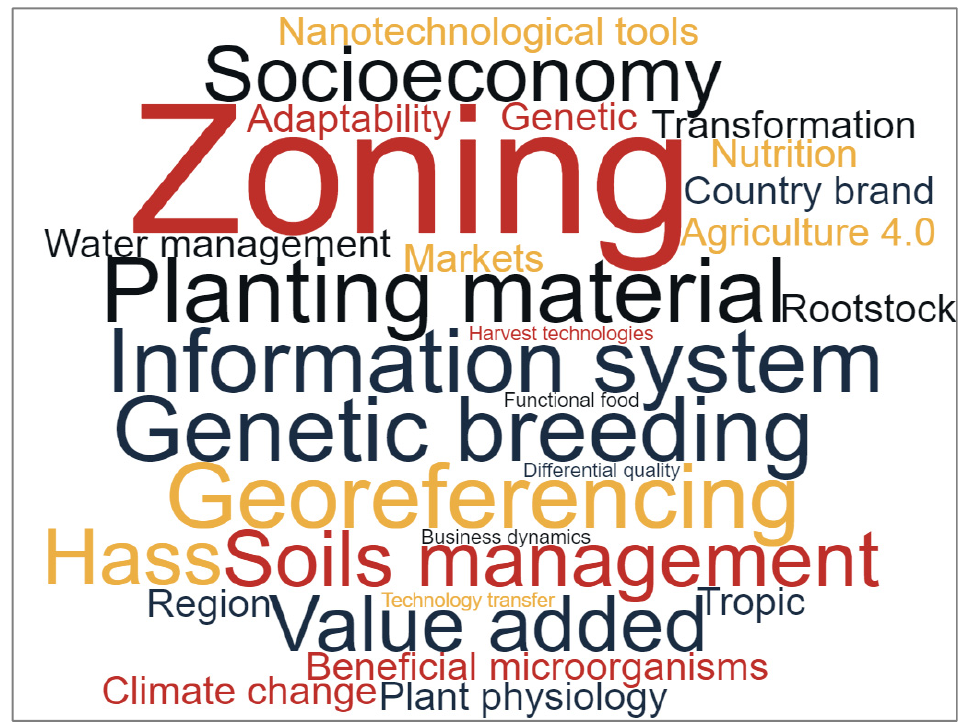
Figure 3. Word frequency analysis of the open responses given by experts regarding the technological demands in avocado cultivation in Colombia.